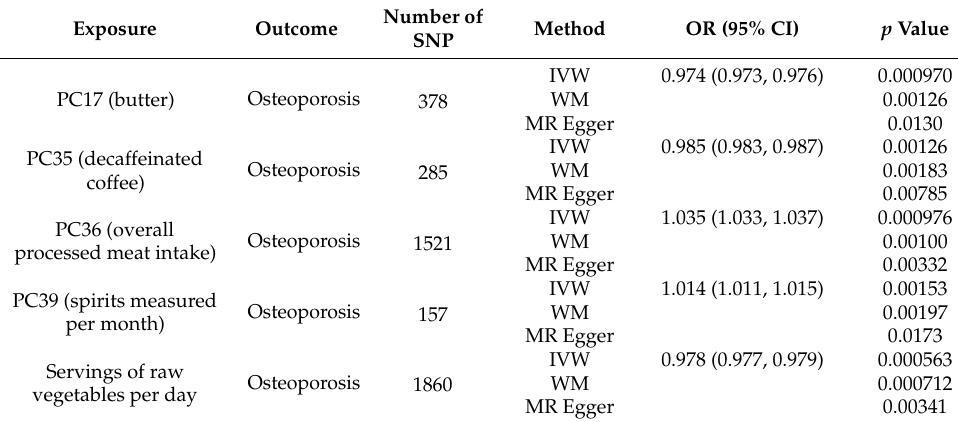
Table 2. The causal analysis results between the dietary habits and OP.